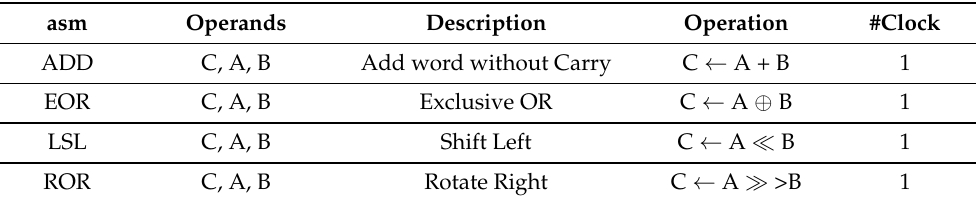
Table 2. Instruction set summary of ARX operations on the 32-bit Advanced RISC Machine (ARM) Cortex-M3